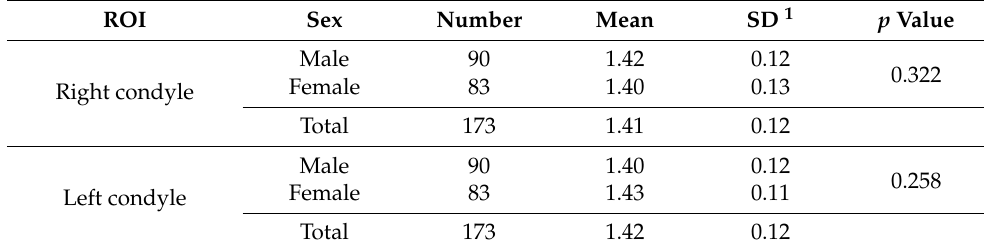
Table 3. FD values of different ROIs for the two sexes in the bruxer group.